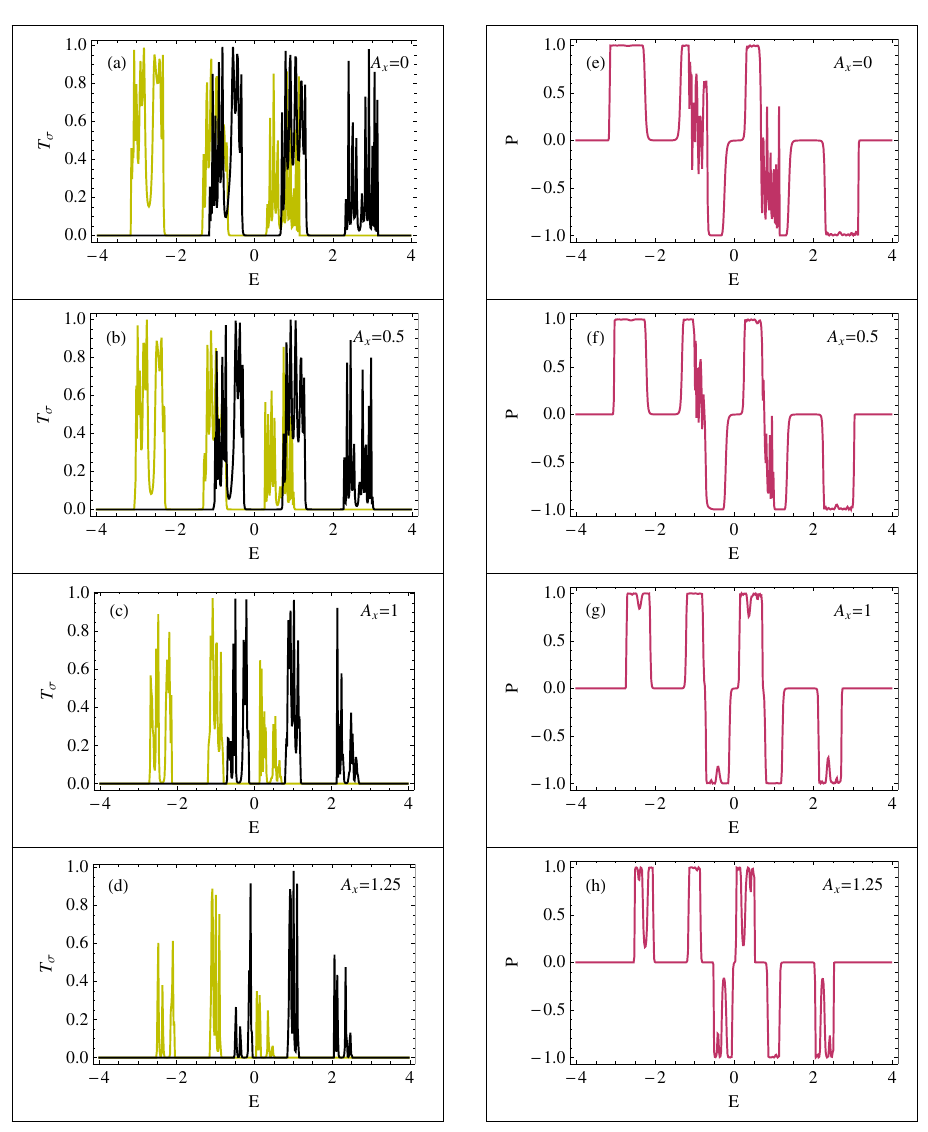
Figure 2. Up and down spin transmission probabilities ( T ↑ → light green color and T ↓ → black color) and spin polarization coefficient P as a function of energy E at four typical values of A x . Here we set θ i = 0 ∀ i and AAH phase φ ν =